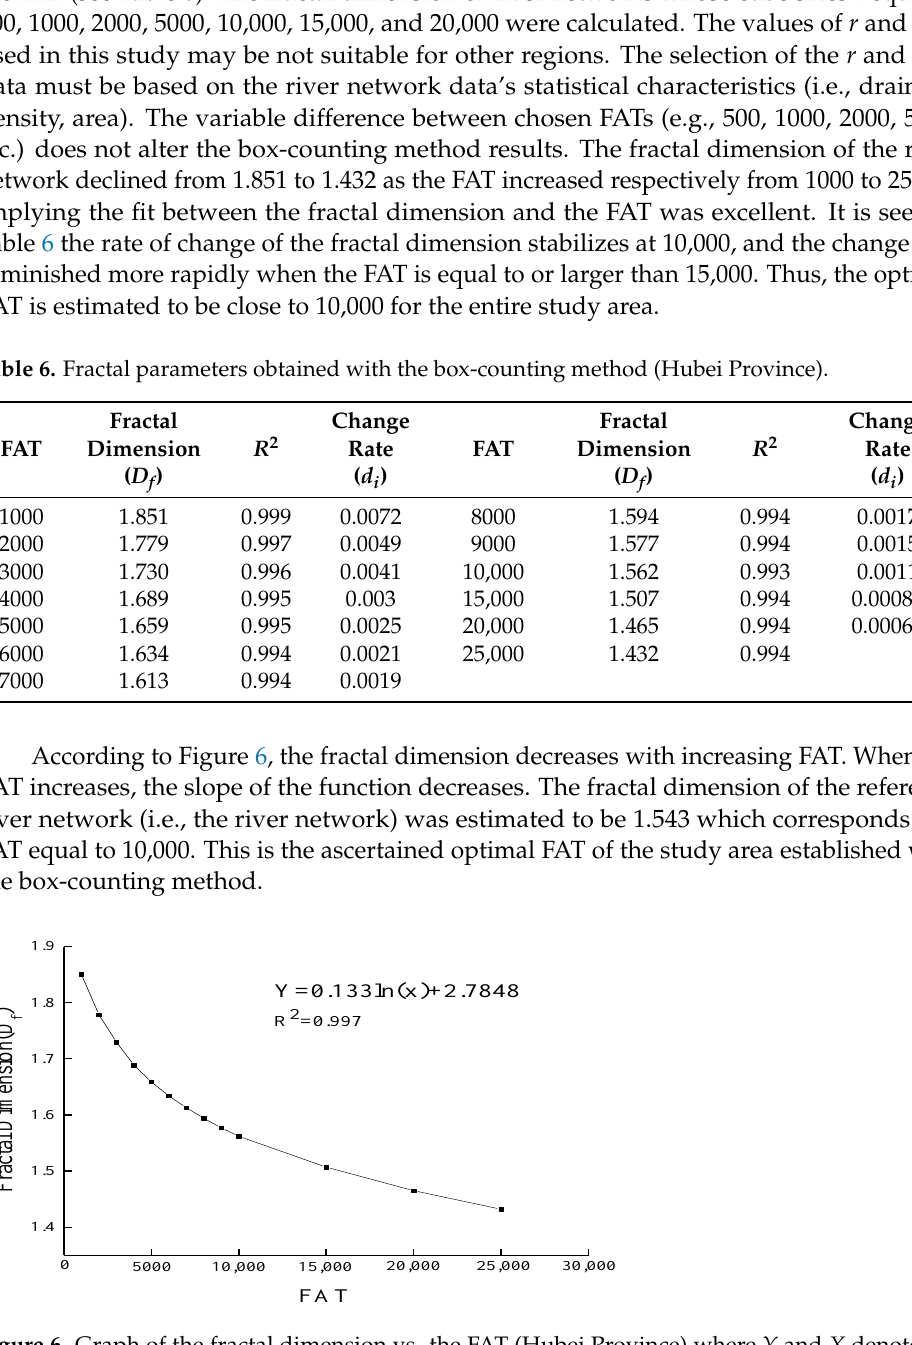
Table 6. Fractal parameters obtained with the box-counting method (Hubei Province).